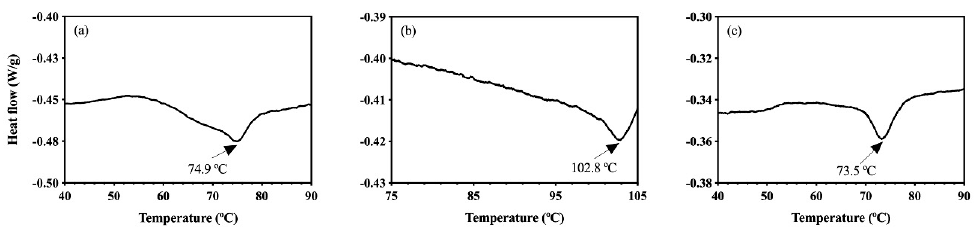
Figure 1. Thermal denaturation profiles of: ( a ) the 5% whey protein ( w / w ) in distilled water solution, ( b ) CD made with 5% whey protein ( w / w ), and ( c ) CE made with 5% whey protein ( w / w ). Arrows show the whey protein denaturation temperature.